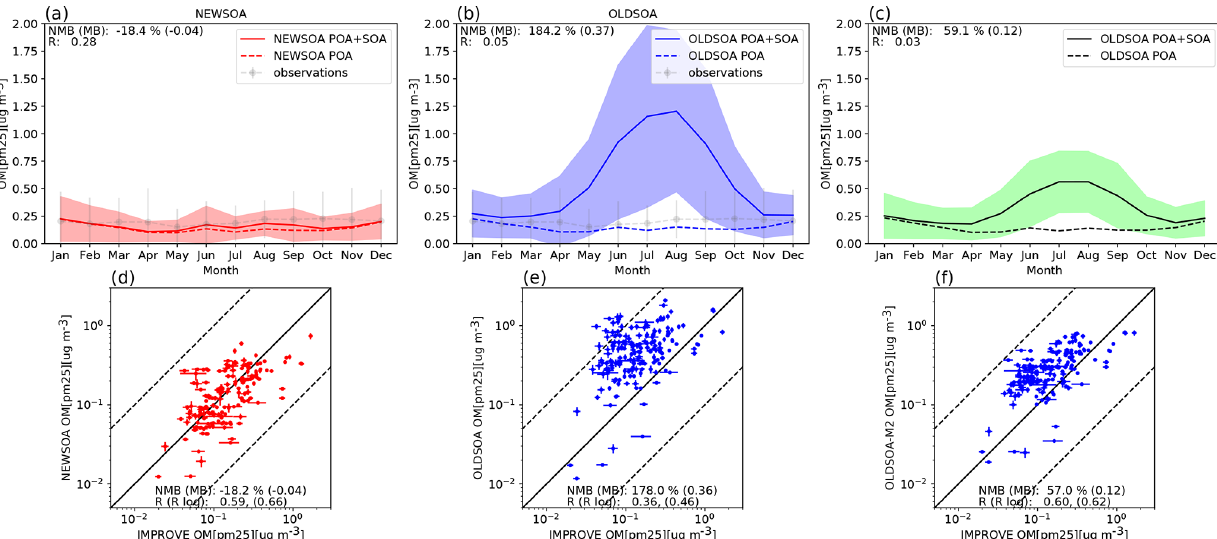
Figure 10. Organic mass concentrations at IMPROVE sites for the three simulations. The top row shows the annual cycle in monthly mean organic mass concentrations for 2010 at the surface in NEWSOA (a) , OLDSOA (b) and OLDSOA-MEGAN2 (c) . The modelled concentra- tions are collocated with observational data temporally and spatially. The shading indicates the standard deviation from the mean. Grey dots show the observed mean with the standard deviation as vertical lines. The bottom row has scatter plots of the annual mean concentration of organic mass in PM 2 . 5 particles at IMPROVE sites in the NEWSOA (d) , OLDSOA (e) and OLDSOA-MEGAN2 (f) simulations. In the scatter plots the height and width of the line of the sign show the standard error of the mean for modelled and observed concentrations, respectively. Table 4. Modelled and observed annual mean OA concentrations, normalised mean bias (NMB) and correlation ( R ) for monthly mean organic mass concentration for EMEP and IMPROVE